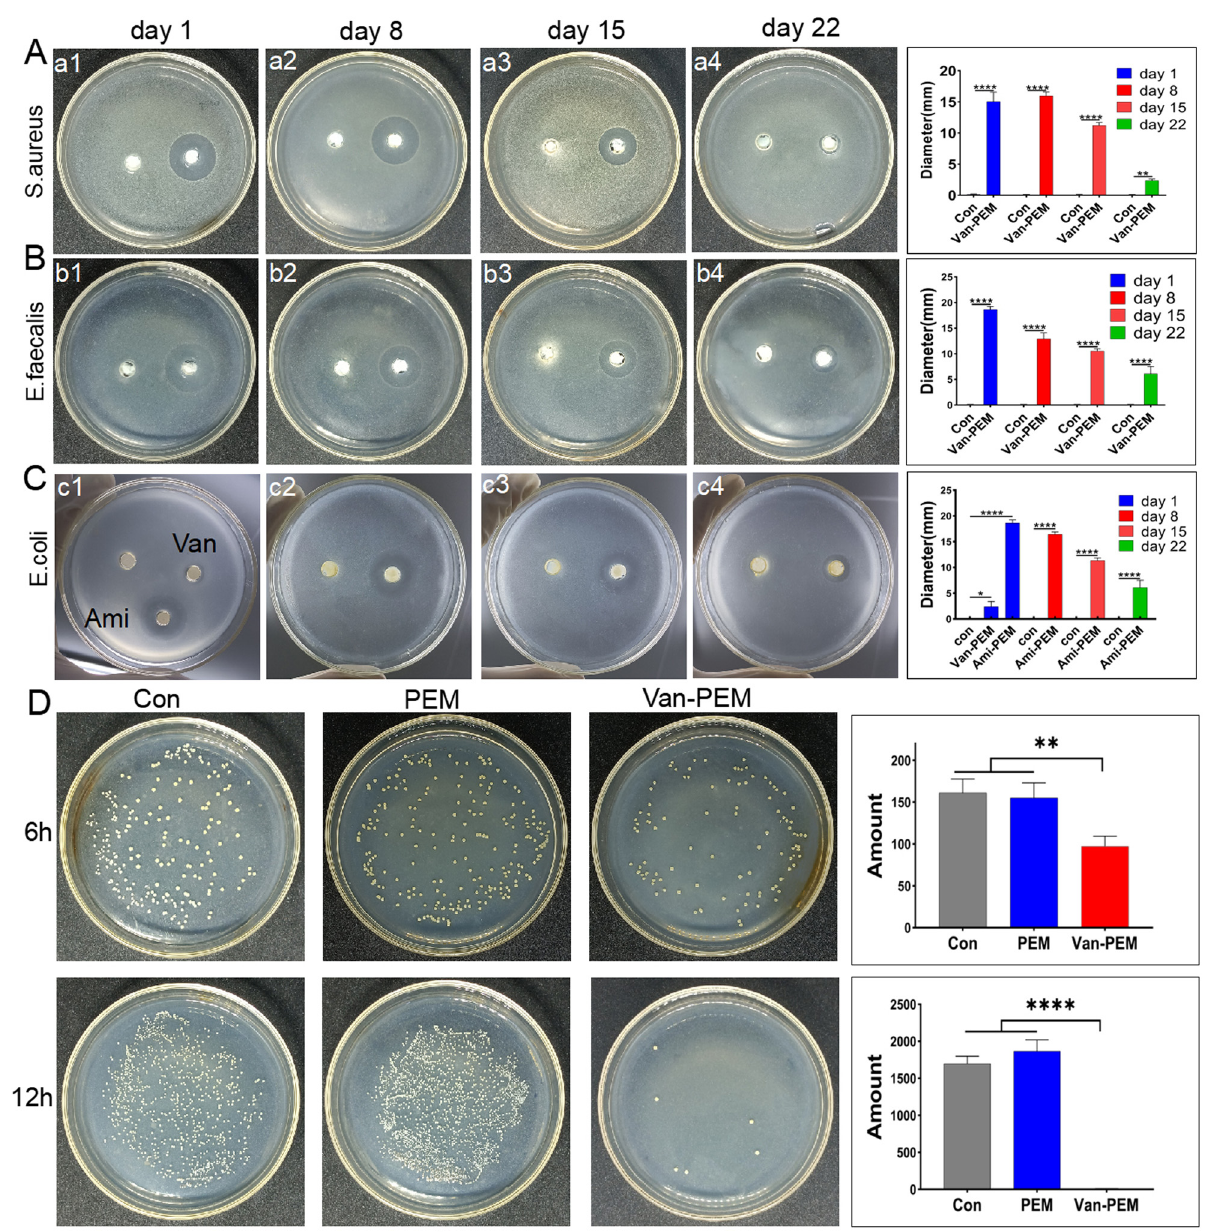
Figure 4: ( a and b ) Bacteriostasis of the Van - PEM hydrogel against S. aureus and Enterococcus on days 1, 8, 15, and 22. It was demonstrated that Van - PEM hydrogel was still able to kill gram - positive bacteria on day 22. ( c ) Bacteriostasis of the Ami - PEM hydrogel against E. coli on days 1, 8, 15, and 22. ( d ) Bacterioplankton killing abilities of the PEM and Van - PEM